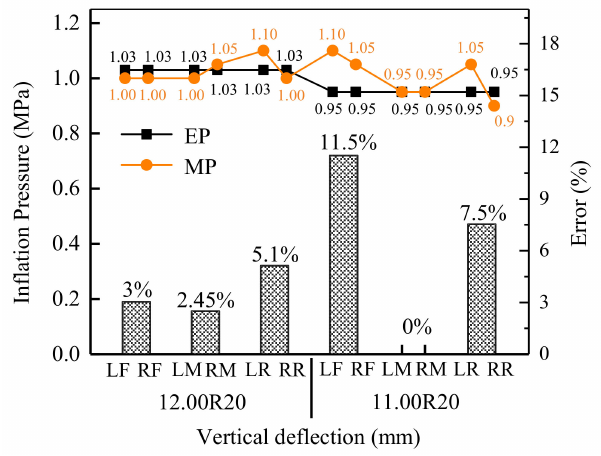
Figure 20. The comparison of the inflation